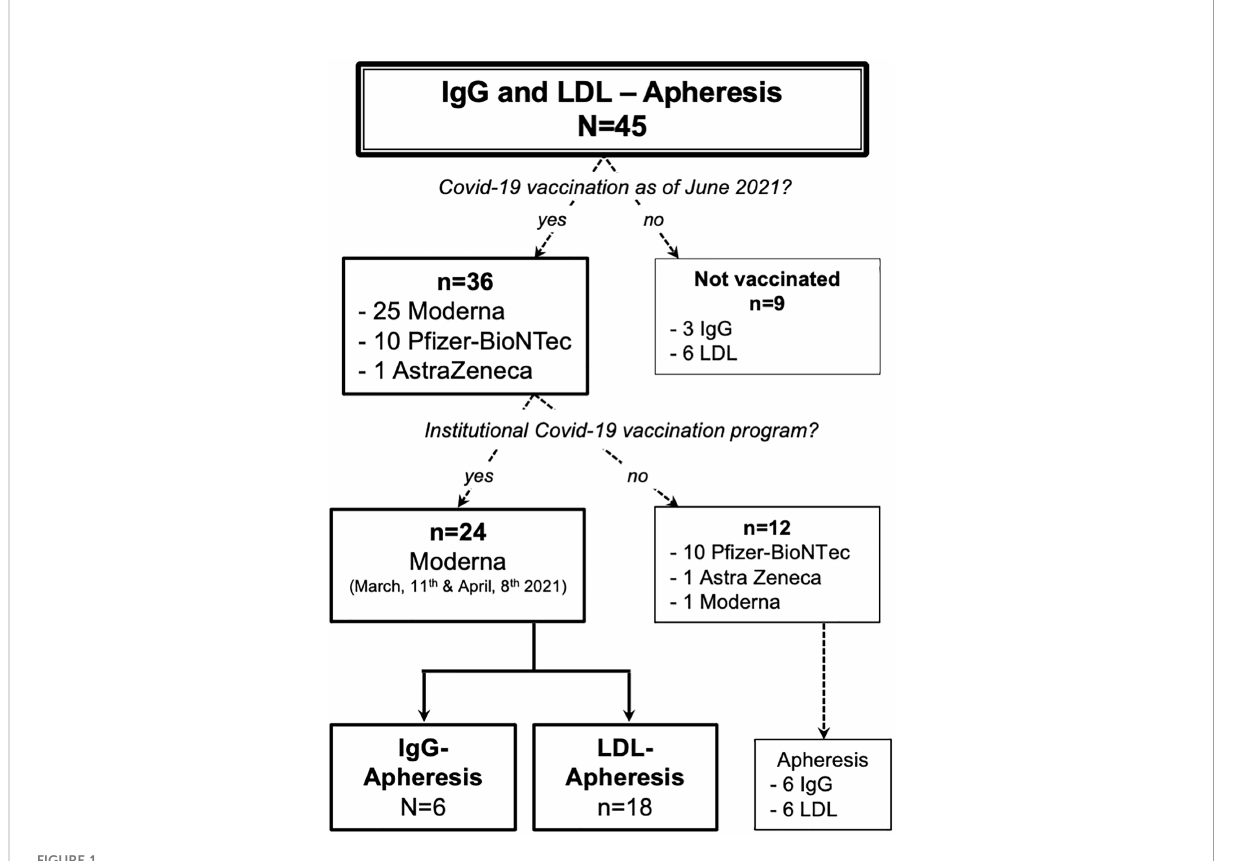
FIGURE 1 Composition of the study cohort.